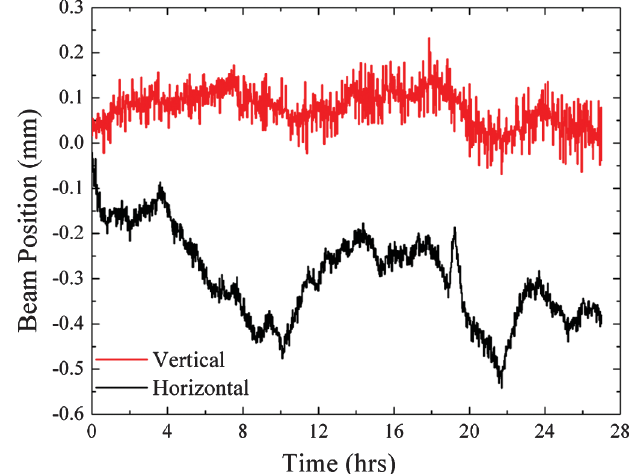
FIG. 7. (Color) Spectrum of the KEK-B circumference varia- tions [21]. The dashed line is for the ATL-law scaling 8 : 2 =f 2 ; the solid red line is for a power-law fit ð 1 : 74 (cid:5) 0 : 2 Þ =f 2 : 21 (cid:5) 0 : 07 .